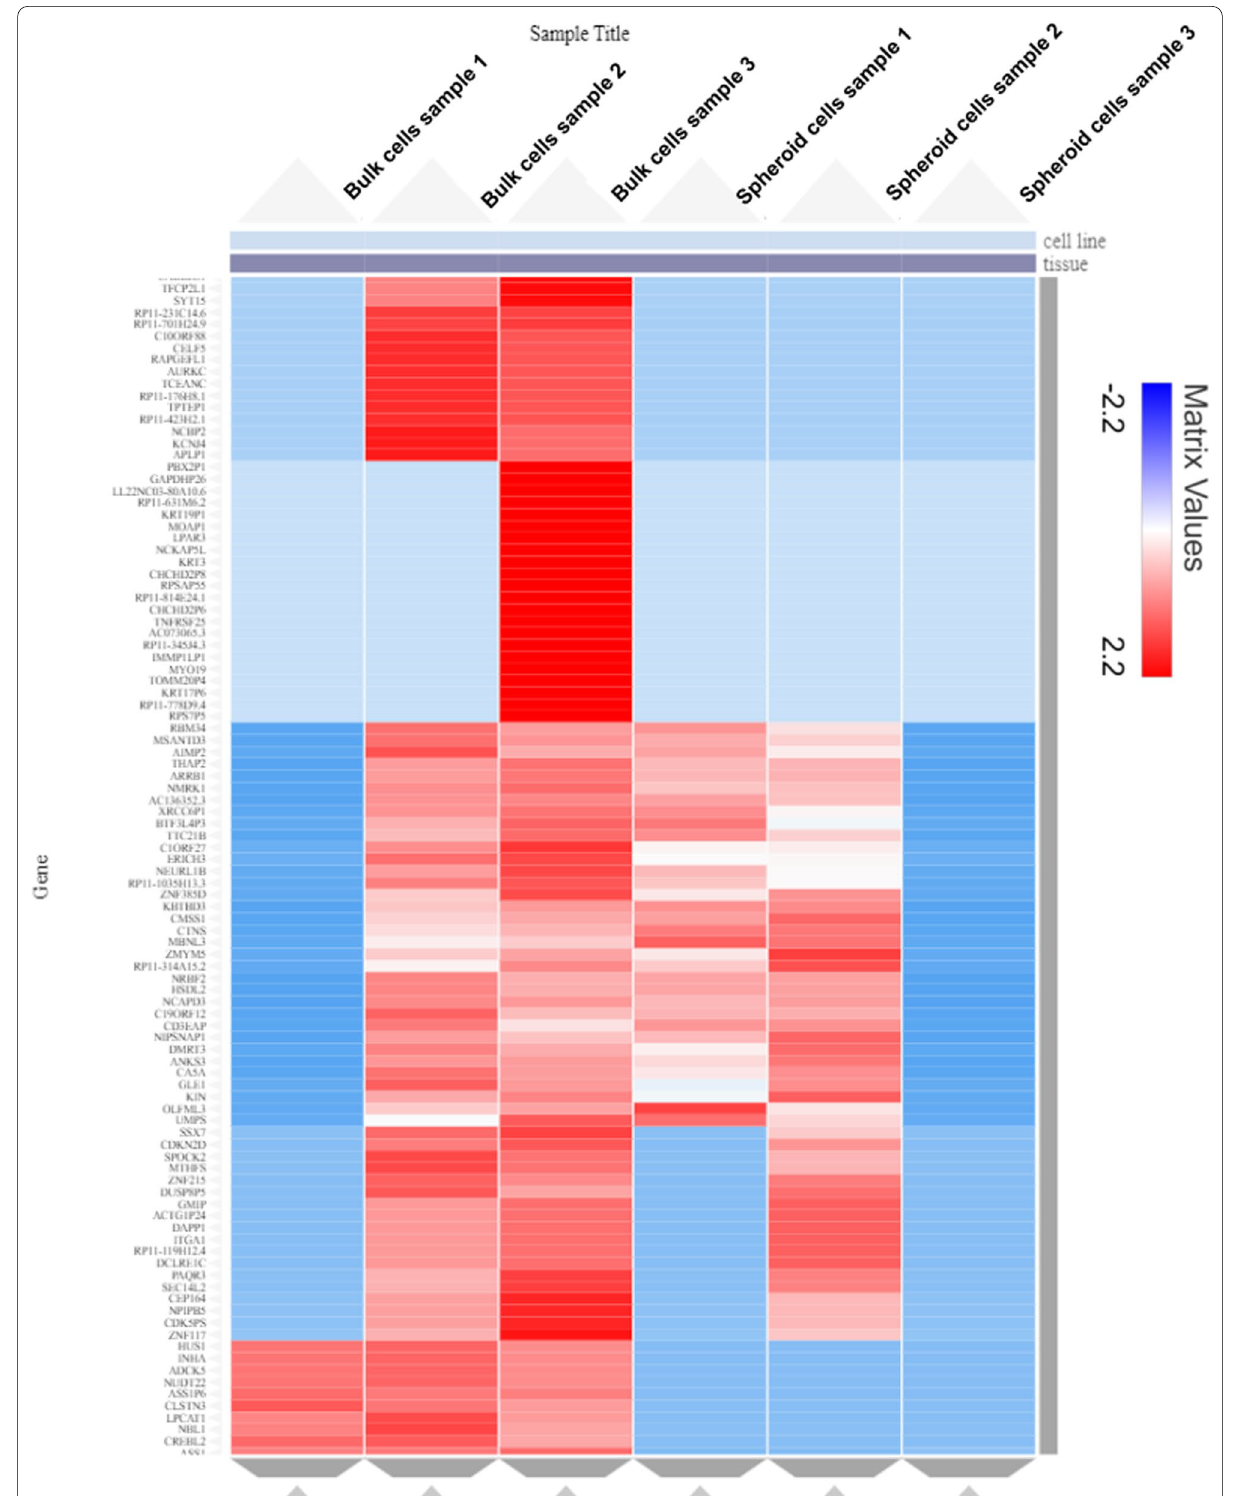
Fig. 2 The figure contains an interactive heatmap displaying gene expression for each sample in the RNA-seq dataset. Every row of the heatmap represents a gene, every column represents a sample, and every cell displays normalized gene expression values. The heatmap additionally features color bars beside each column which represent prior knowledge of each sample, such as the tissue of origin or experimental